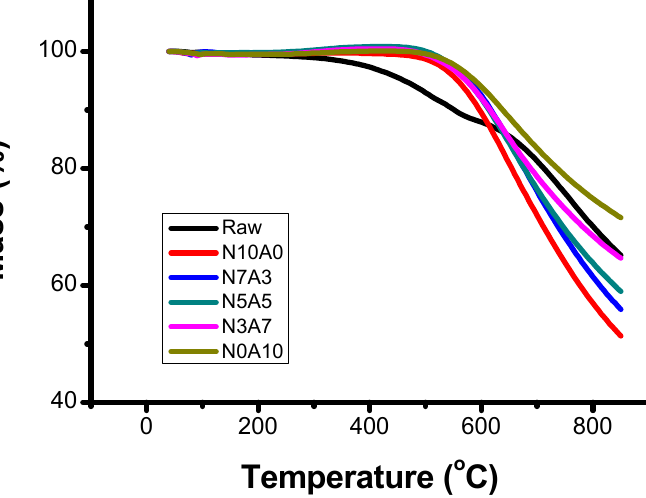
Figure 1. Thermogravimetric analysis (TGA) of binderless cokes manufactured according to flow ratio of nitrogen and air.